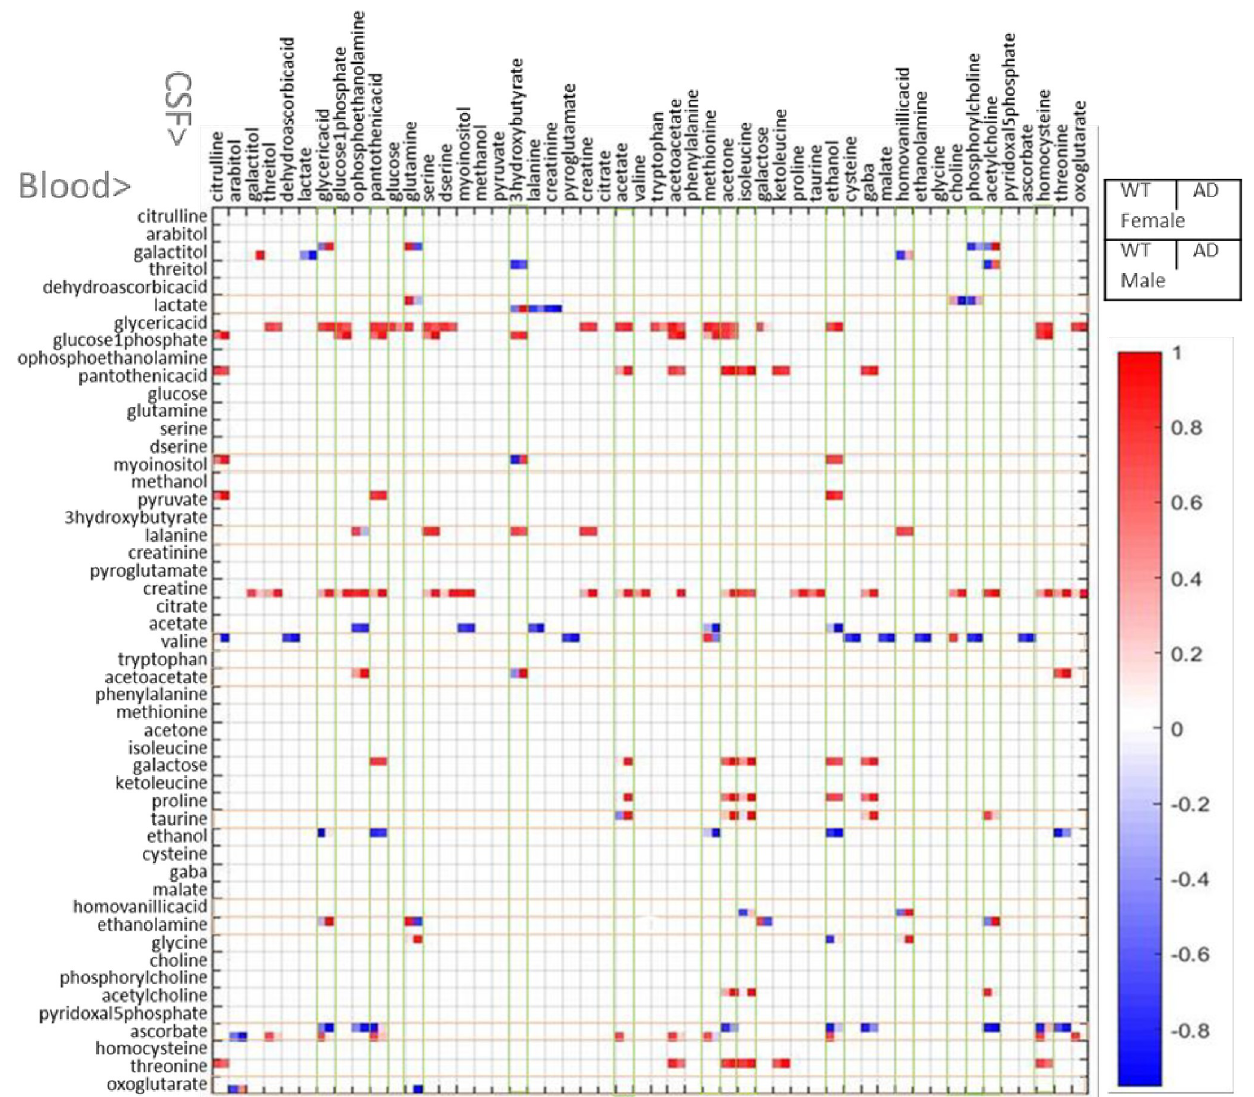
Fig 6. Significant correlations between metabolites in blood (shown in column) and CSF (row) represented in 2x2 representations for WT and APP/ PS1 female and WT and APP/PS1